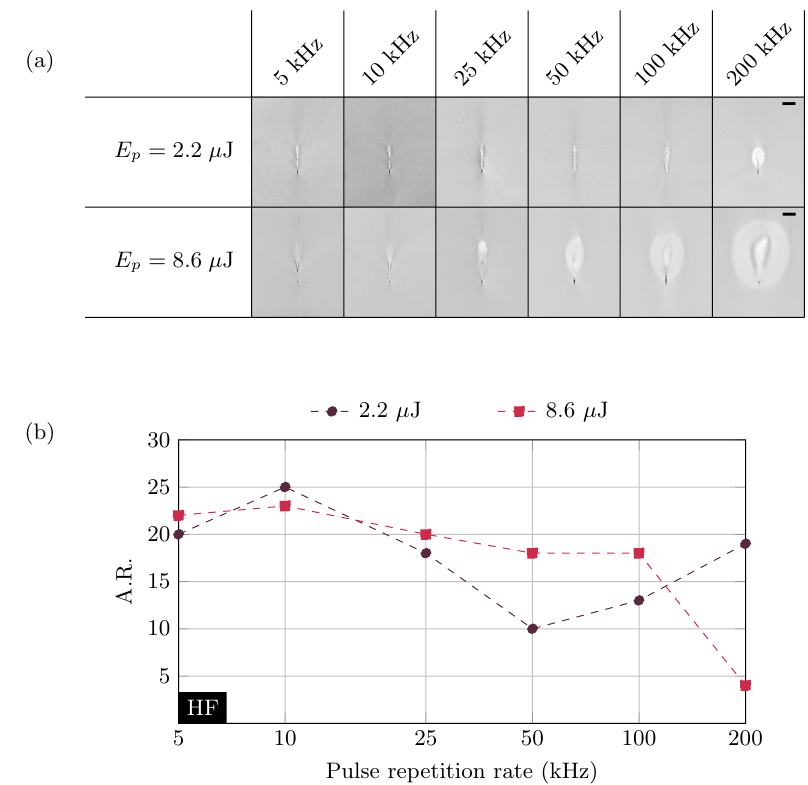
Figure 4. ( a ) Microscope pictures of the cross-section of tracks irradiated with two different values of E p , and repetition rates ranging from 5 kHz to 200 kHz. Scalebars correspond to 5 µ m (all pictures in the same row have the same scale). The scan speed is scaled proportionally to the repetition rate, keeping as reference v t = 1 mm/s at 25 kHz. ( b ) A.R. of the etched cones obtained from the above-illustrated tracks, as measured after 15 min immersion in HF